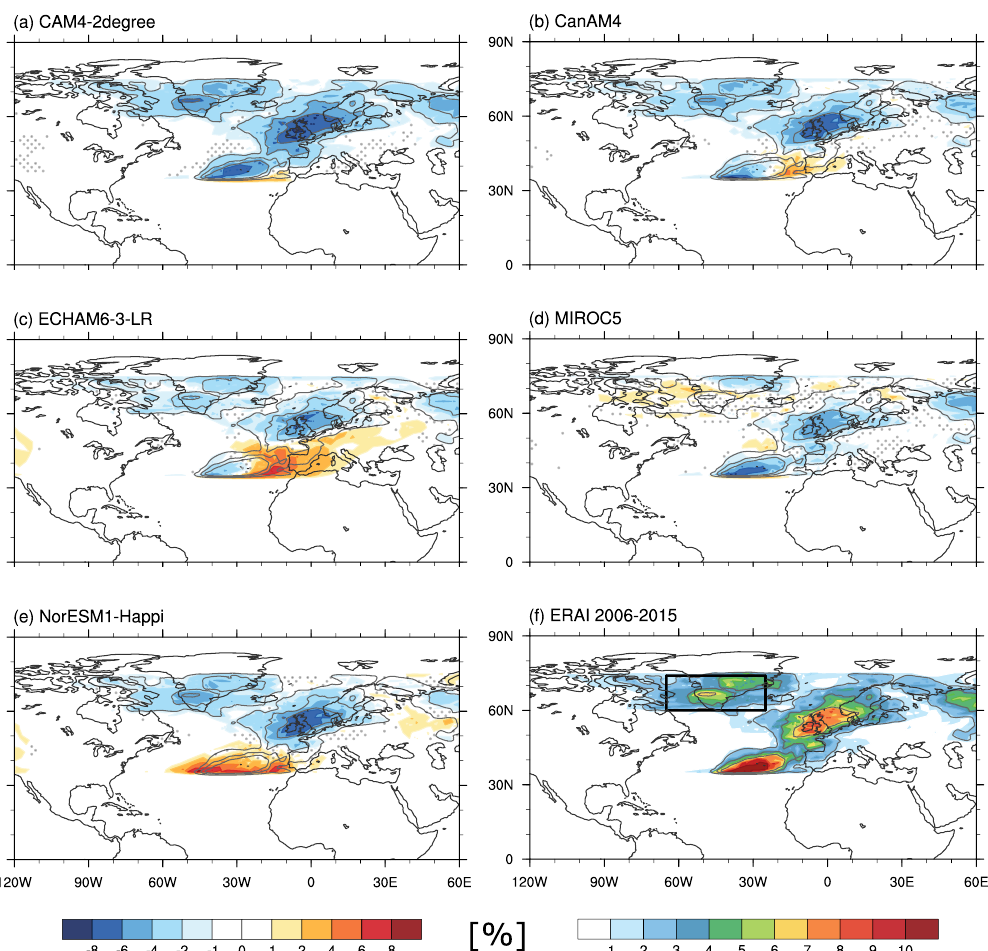
Figure 1. (a–e) Bias in winter (DJF) blocking frequency for the five models (ensemble mean of the blocking frequency minus ERA-Interim) and (f) ERA-Interim DJF blocking climatology for 2006–2015 (in frequency, as %). Dark grey lines show the smoothed 2%, 4%, and 6% contours for ERA-Interim (2006–2015). The black box shows the main region of Greenland blocking in ERA-Interim. Biases that are not significant at the 90% level are dotted, and there are no dots where there is no